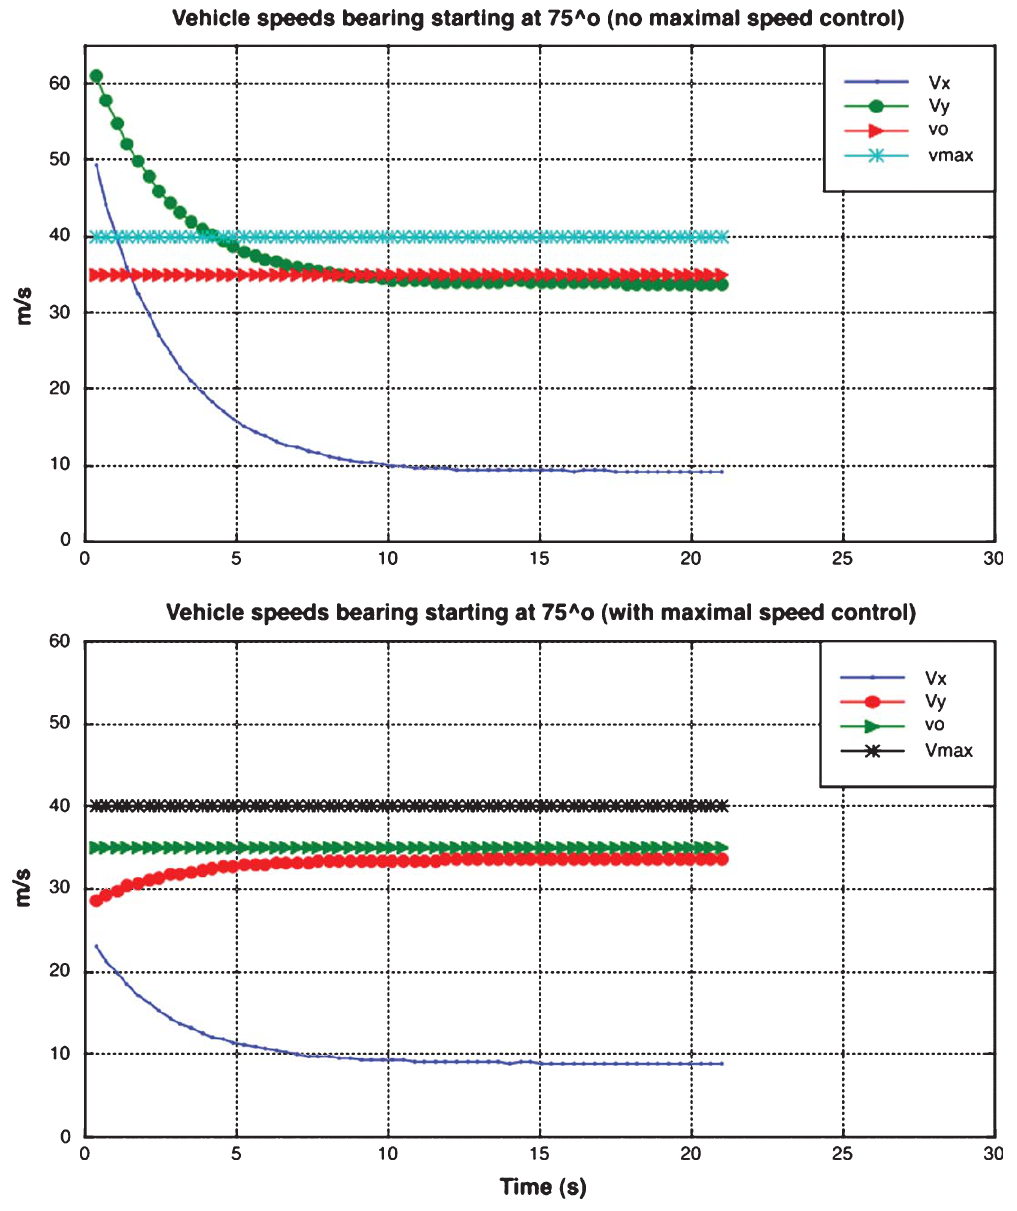
Fig. 2. Above: reference velocity control; Below: maximal allowable velocity control. The parameters for this instance are ˆ v x = 55 m/s and ˆ v y = 65 m/s with an angle of motion oriented at 75 o with an η = 0 . 125, v o = 35 m/s and v max = 40 m/s .